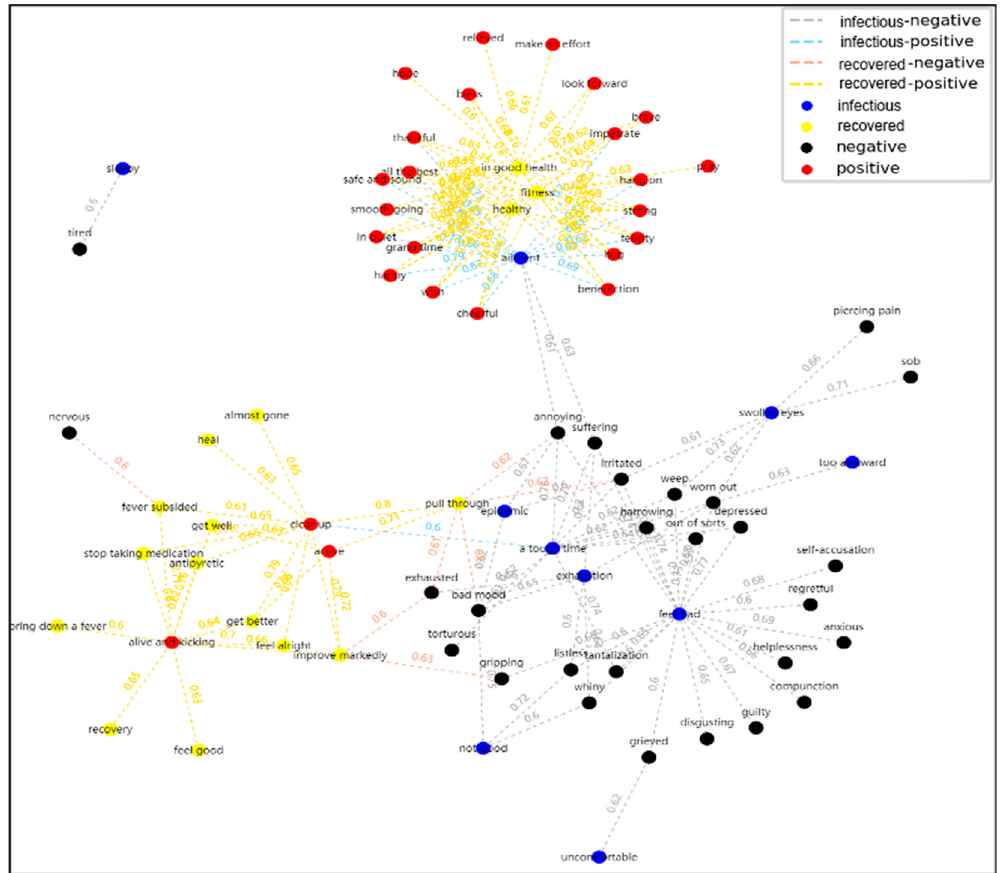
Figure 11. Force-Directed Graph of Words’ Similarity.